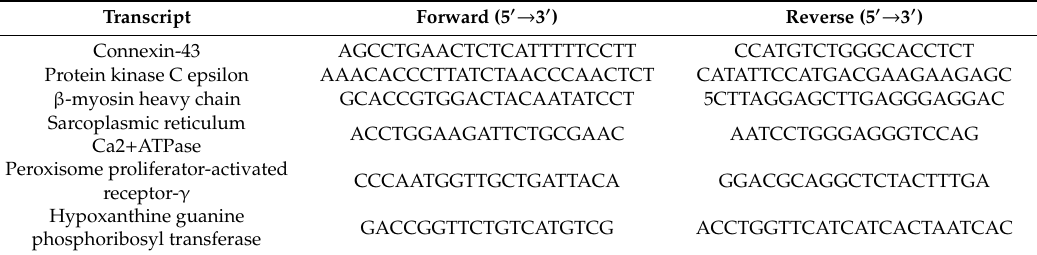
Table 4. Primer sequences for messenger RNA transcript